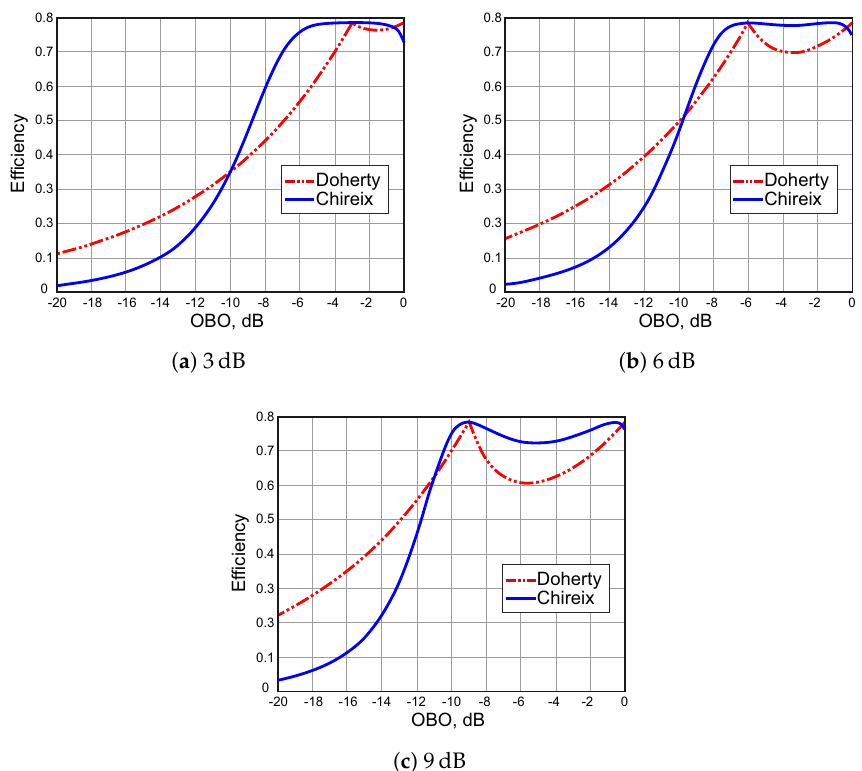
Figure 13. Efficiency vs. OBO curves of Doherty and Chireix